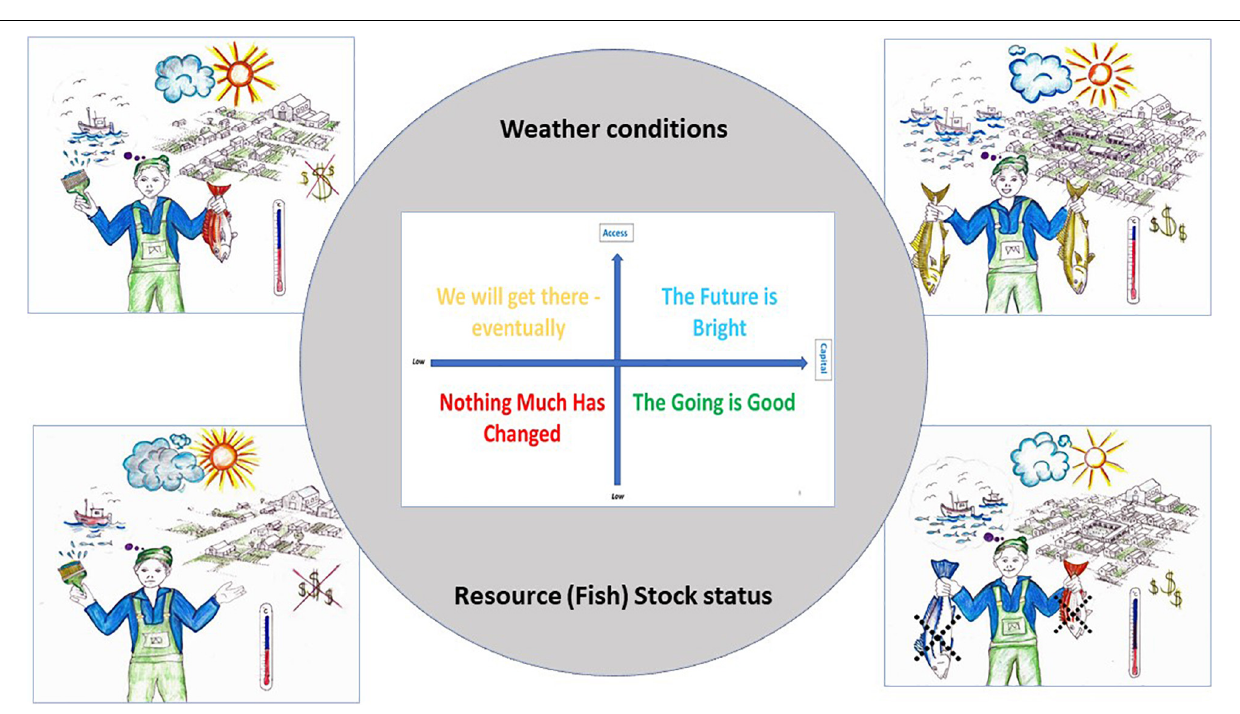
FIGURE 6 | Representation of the four scenario stories were designed around two Key driving forces (KDFs) defined by participants – access to (fishing) resources and access to (financial) capital. The context of two additional KDFs – resources (fish) availability and climate variation, were integrated with the fishers’ stories into four distinct stories – “Nothing much has changed,” “We well get there, eventually,” “The future is bright” and “The going is good” (adapted from Gammage,